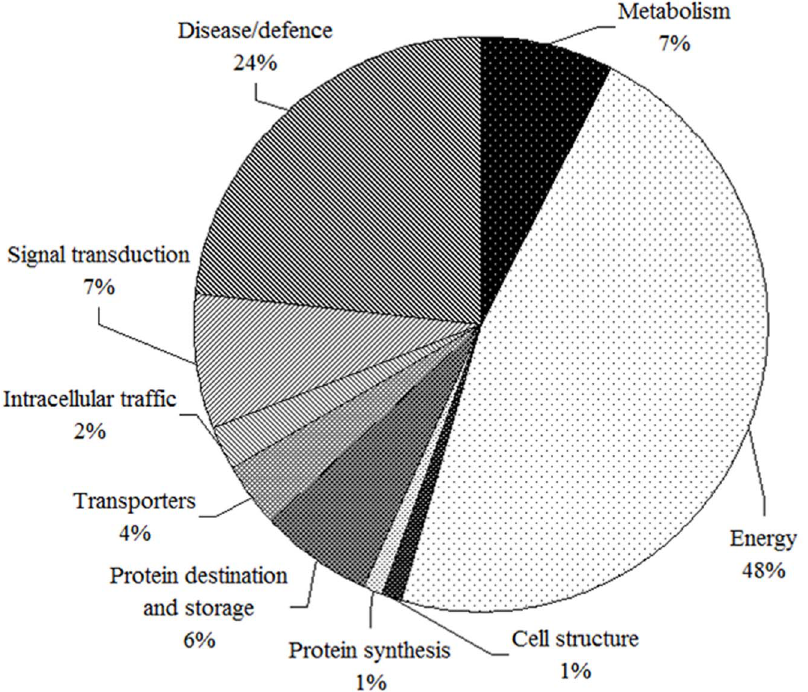
Figure 4. The functional category distribution of all identified proteins in response to heat stress.